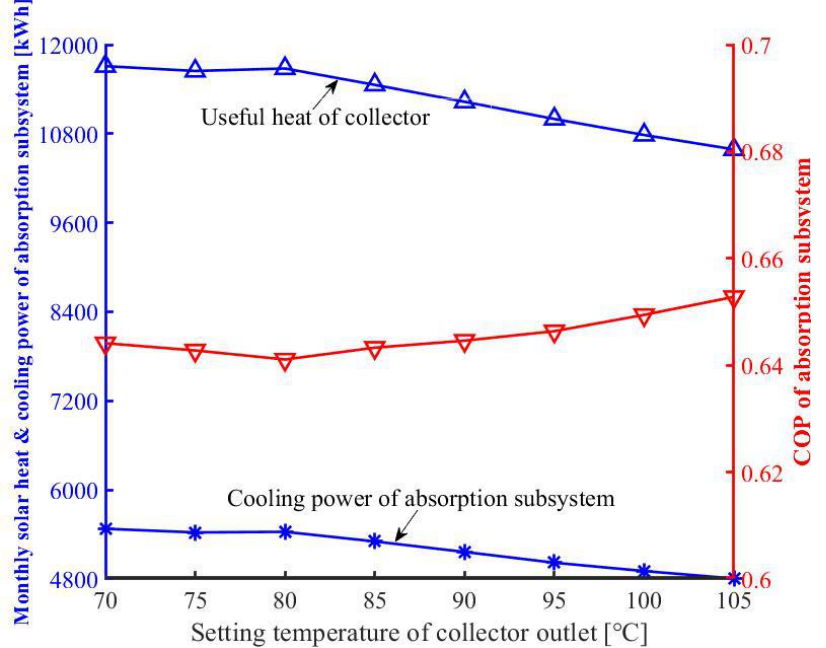
Figure 11. Impact of setting temperature of collector outlet.